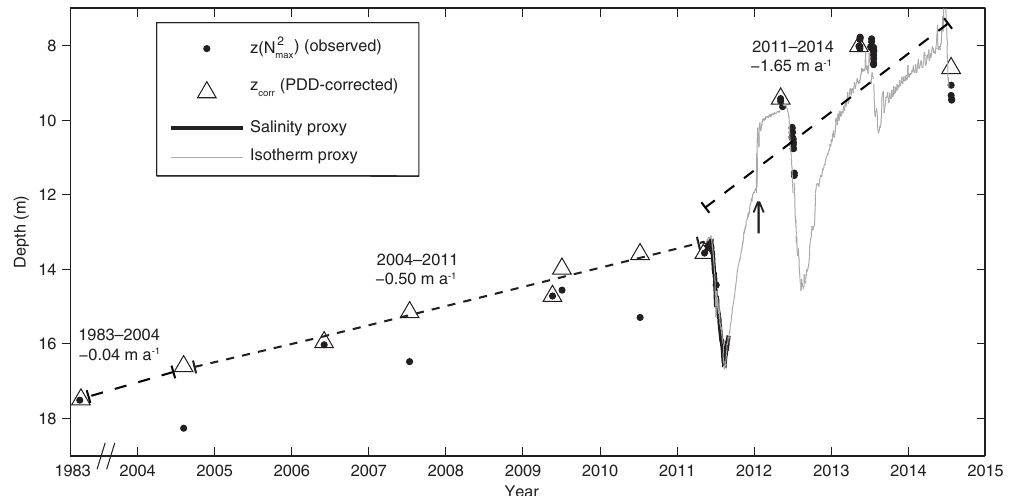
Figure 9. Interannual and seasonal changes in the depth of the MEL from 1983 to 2014. Shown are the observed lake depths from CTD (cid:16) (cid:17) z(N 2 max ) profiling , PDD-corrected lake depths ( z corr ; see Eq. 4) that account for the seasonal timing of the profile, and depths determined from moored salinity and temperature records from May 2011 to July 2014. Note the discontinuous x axis between 1983 and 2004. To reduce clutter, z corr are shown only for the first profile collected during each field campaign after 2011. The arrow indicates the mixing event in January 2012. Dashed lines indicate a linear regression of z corr for the periods 1983–2004, 2004–2011, and